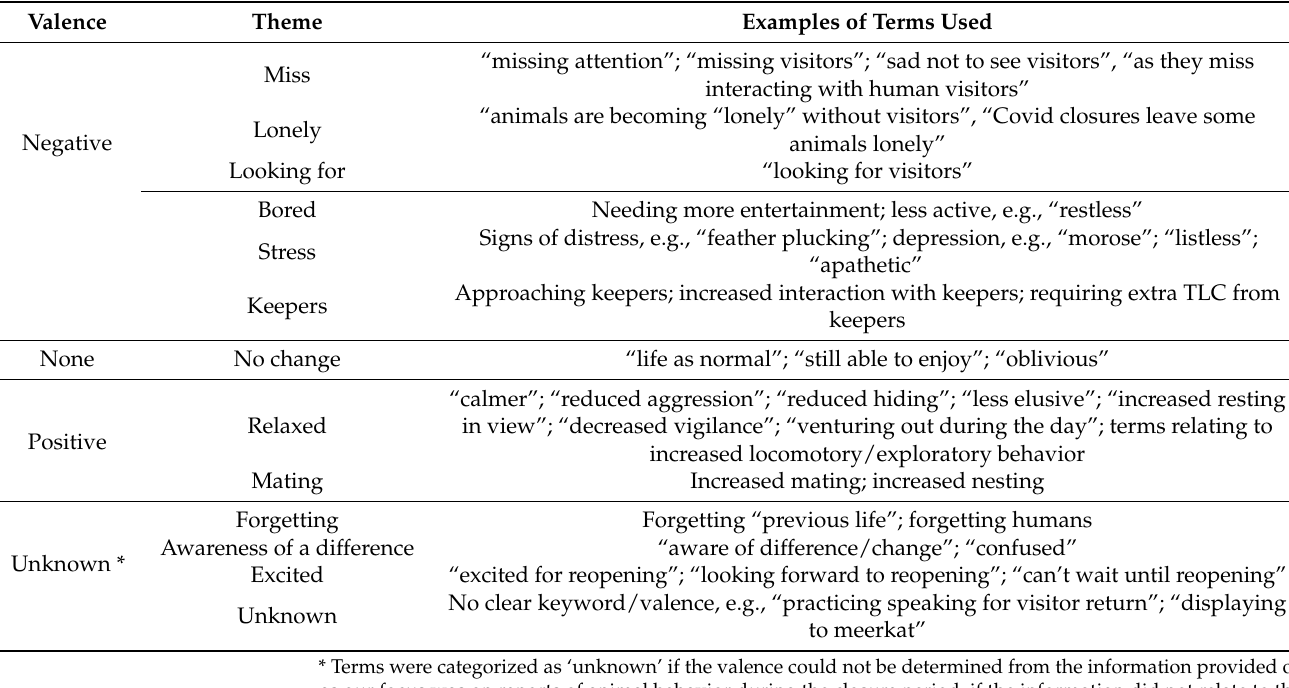
Table 3. Examples of the way in which search terms were used in the Facebook posts and news